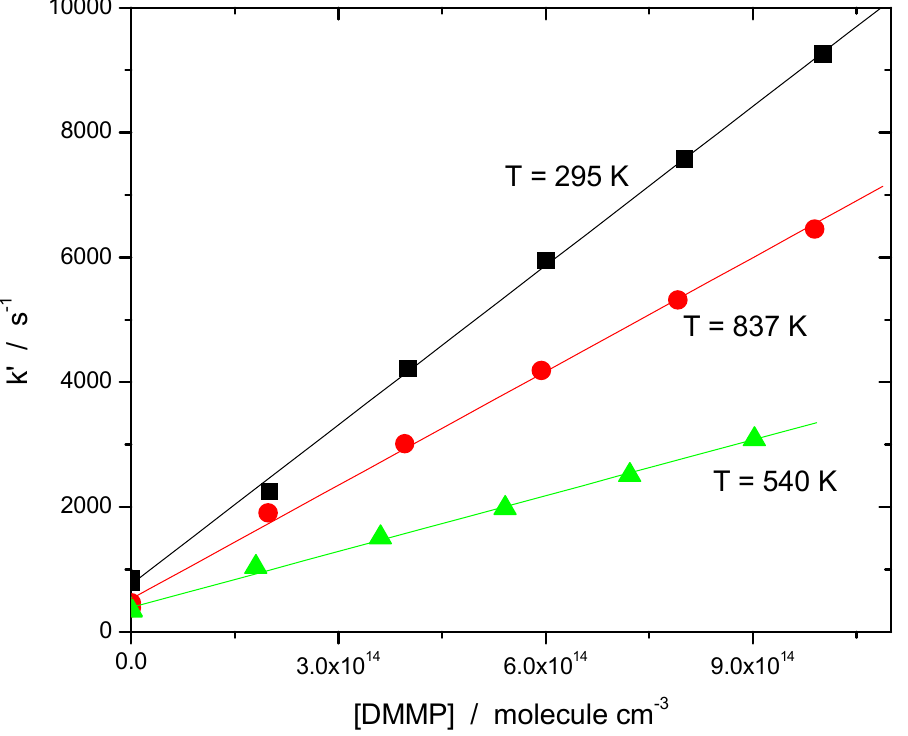
Figure 3. Sample dependences of the “initial slope rate constant, k’ ” on concentration of DMMP at three temperatures (low, high and an intermediate). Photolysis of N 2 O/H 2 O/DMMP/He mixtures at 193 nm. The slopes yield the rate constants of the target reaction (1). Negative temperature dependence (decrease of the rate constant with temperature) at low temperatures as well as positive temperature dependence (increase of the rate constant with temperature) at high temperatures are apparent. Table 2. Experimental conditions for the experiments with N 2 O/H 2 O/DMMP + 193.3 nm. All meas- urements at 1.00 ± 0.02 bar (He).